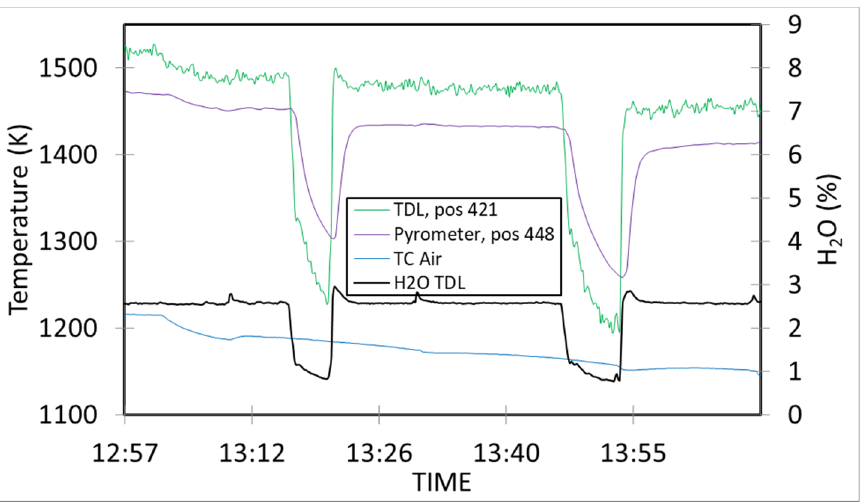
Figure 6. Online measurements of T (TDL, Suction pyrometer, TC) and H 2 O (TDL) during the FO combustion (Day 2).